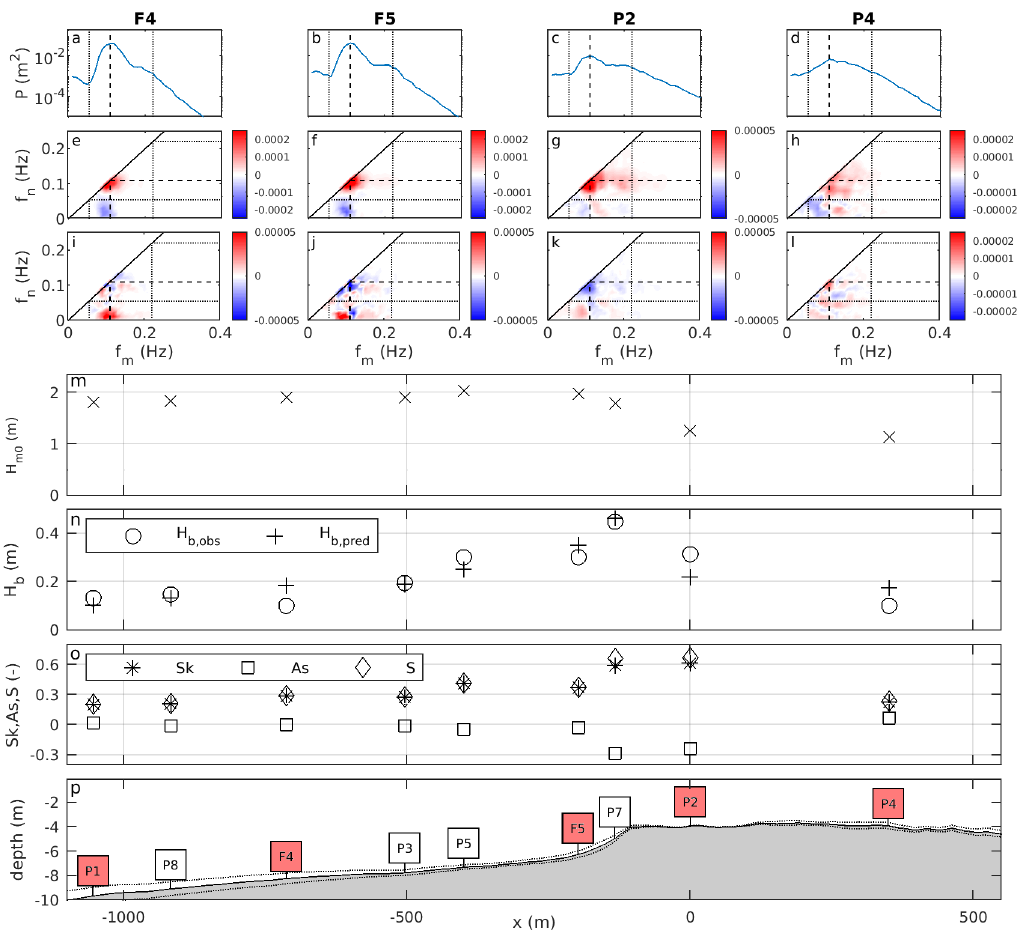
Figure 3. Characterization of the wave field for a selected burst on 4 October 2017 at 12:00. Panels ( a – l ) show the spectrum ( a – d ), real part of the bispectrum ( e – h ) and imaginary part of the bispectrum ( i – l ) at locations F4, F5, P2, and P4. Panels ( m – p ) show the evolution of the sea-swell wave height H m 0 ( m ); the observed and predicted bound wave height in the super harmonics, H b , obs and H b , pred ( n ); and dimensionless sea-swell wave shape parameters Sk , As , and S ( o ) at all locations (see panel ( p ) for information on the deployment depths). The dashed lines in the spectra and bispectra indicate f peak , the dotted lines f peak /2 and 2 f peak . The thick black diagonal lines in the bispectra are the symmetry lines. Note that the limits of the color scales for the bispectral plots are not all the same. The bathymetry of the main transects is shown in panel p, with ± one standard deviation indicated by black dashed lines representing bathymetric variability for cases with non-oblique incoming wave directions ( − 45 ◦ < θ < 45 ◦ ). Sensor locations are indicated by the red (if sensor is on main transect) and white boxes (if sensor is not on main transect; sensor is placed such that the mean depth is the same as the depth on the main